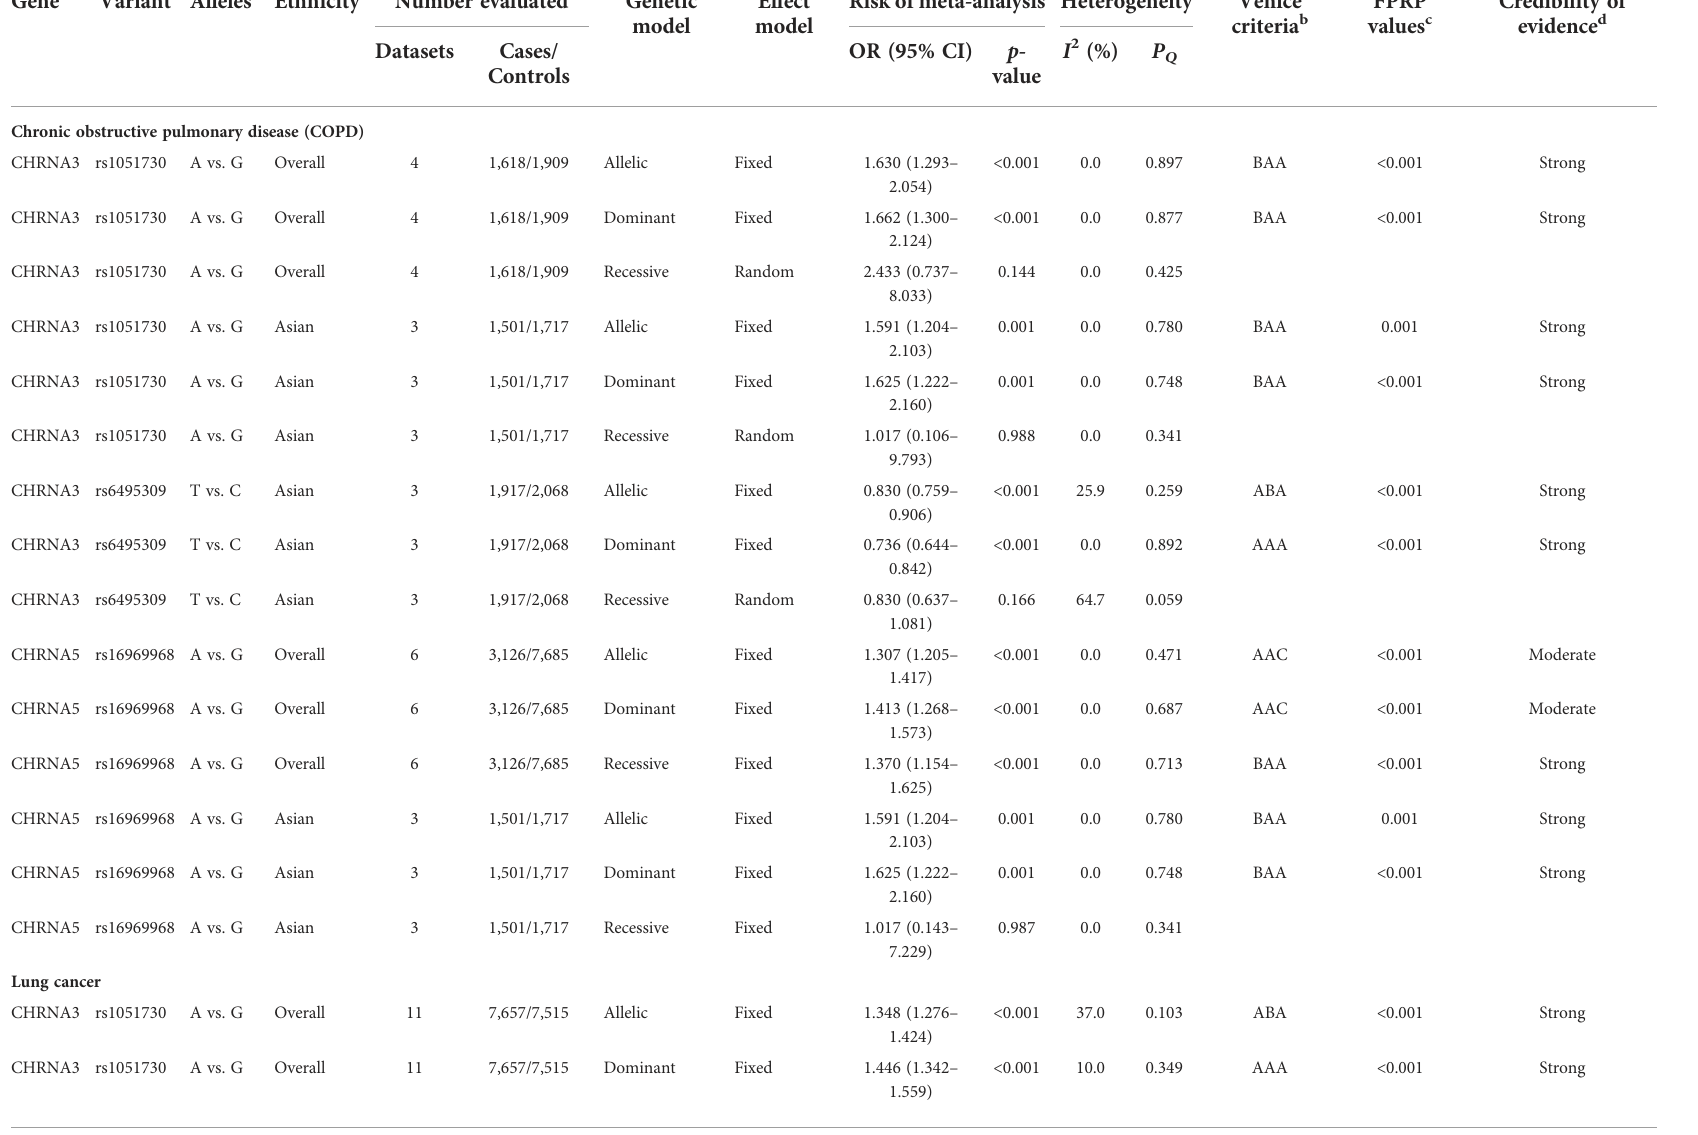
TABLE 1 Genetic variants showing summary ORs for different disease risks in main meta-analyses in all three genetic